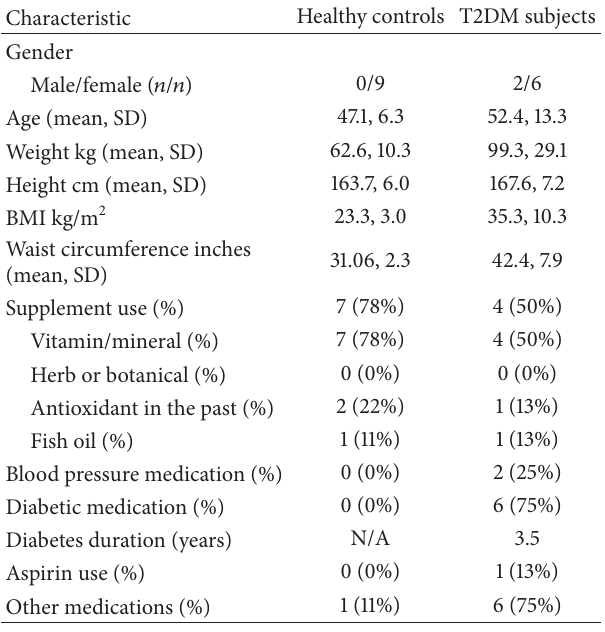
Table 2: Baseline characteristics of healthy controls and subjects with type 2 diabetes (T2DM).